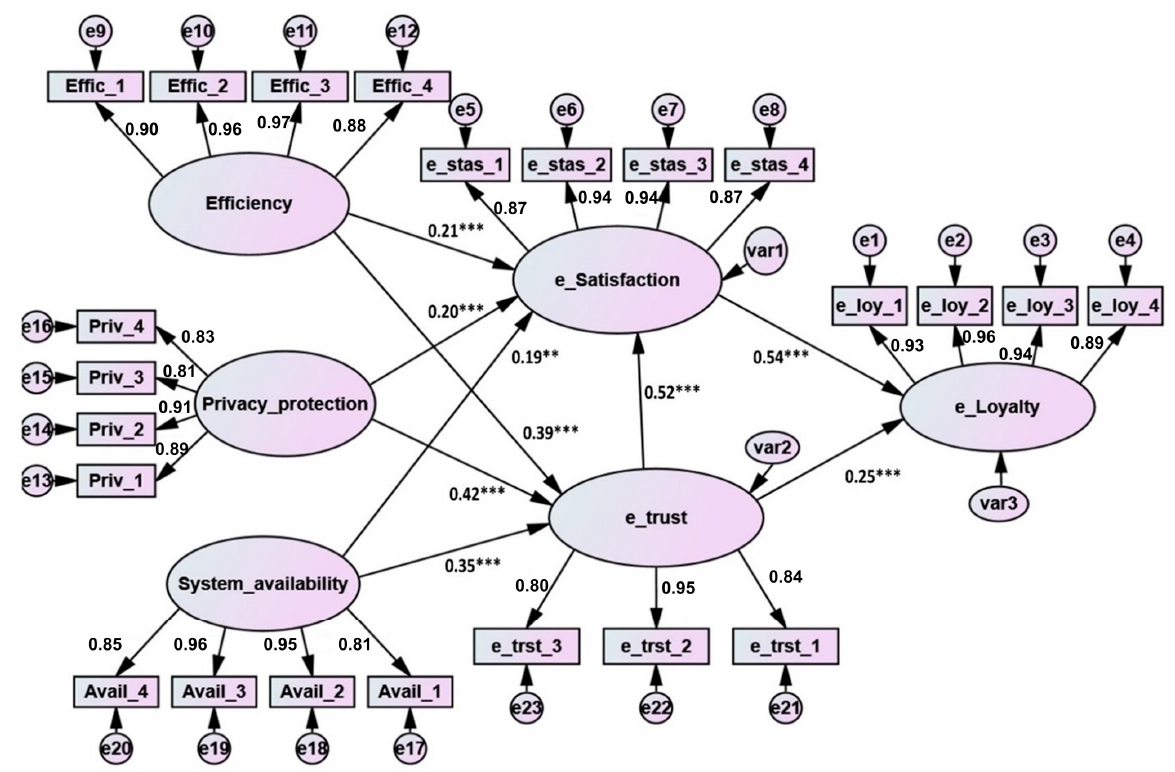
Figure 2. structural and measurement model ( ** p < 0.01; *** p < 0.001) . Figure 2. Structural and measurement model (** p < 0.01; *** p < Table 3. The results of the structural proposed model.